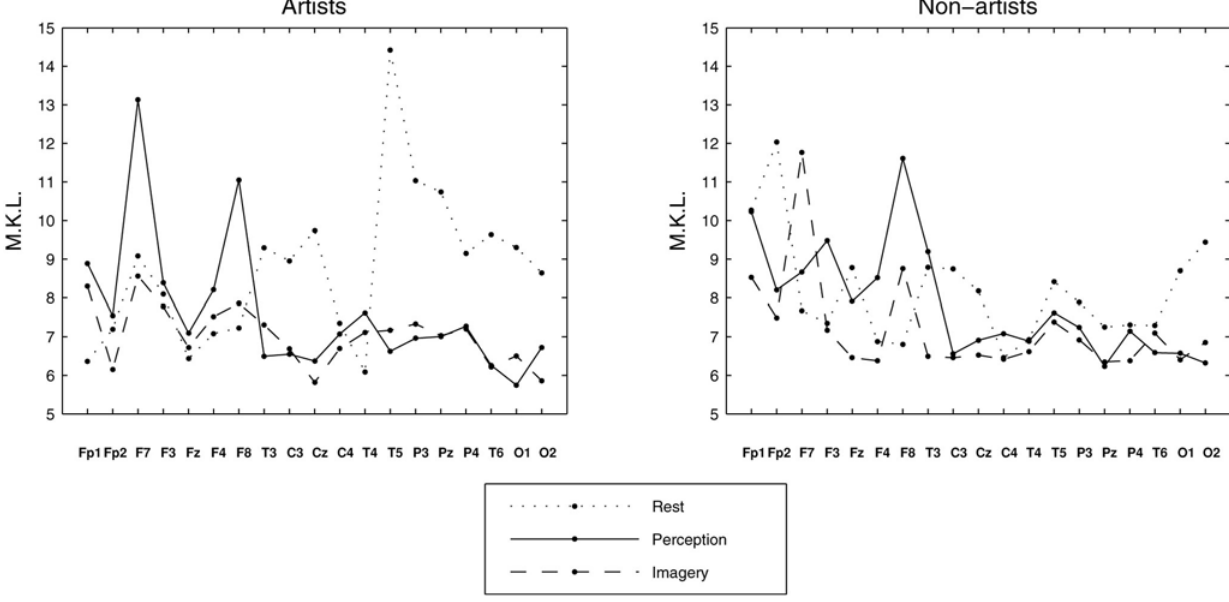
Figure 6. Universality of individual brain regions across participants. Universality across participants as measured by MKL divergence measure for the two groups, (a) artists and (b) non-artists, during three states, rest (dotted line), visual perception (solid), and mental imagery (dash- dot), respectively.